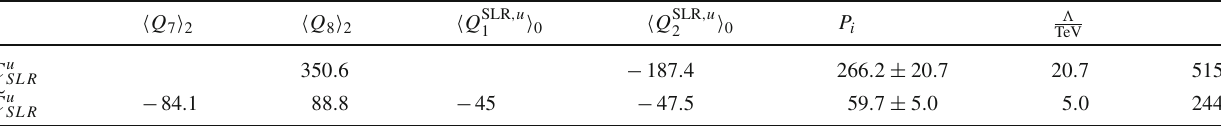
Table 10 Coefficients p ( I ) and P i of the master formula (18)–(19) as well as suppression scale (cid:8) (last column) from RLLR type operators of ij Class E with flavour structure ( ¯ sd )( ¯ uu ) . Empty entries correspond to vanishing coefficients